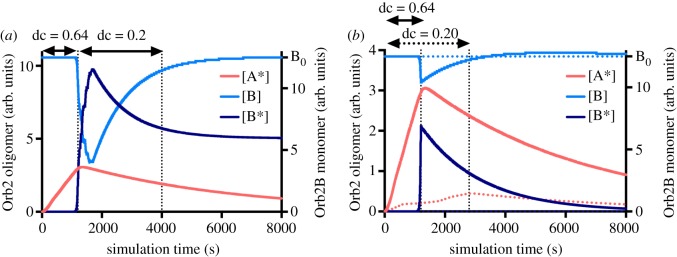
Consequences of the summation property of the Orb2 model. (a) The combination of a relatively short and strong stimulation (ν = 0.15 Hz, d.c. = 0.64, Δt = 1200 s), with a consolidating low-frequency stimulation (ν = 0.15 Hz, d.c. = 0.20, Δt = 2800 s) induces the long-term aggregation of Orb2, while (b) each single stimulation (solid/dotted lines) does not.